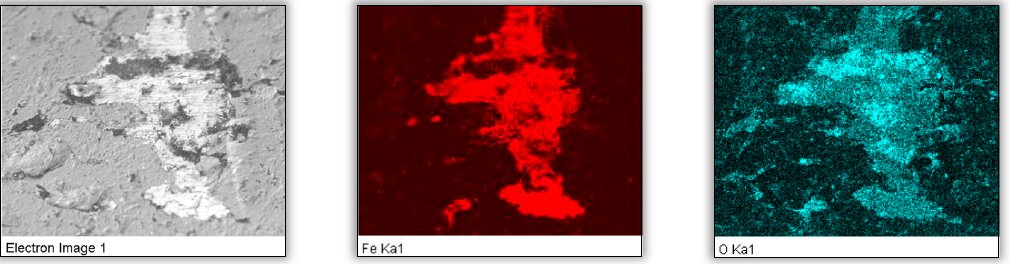
Figure 15. Results of the analysis of the chemical composition of wear products on the shaft surfaces.